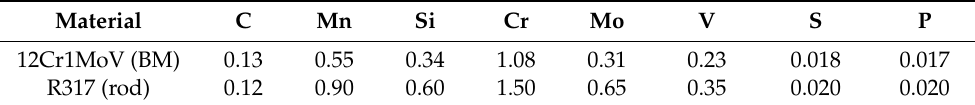
Figure 1. Schematic of welding groove and weld bead distribution. Table 1. Chemical compositions of 12Cr1MoV steel pipe and R317 rods (wt. %).